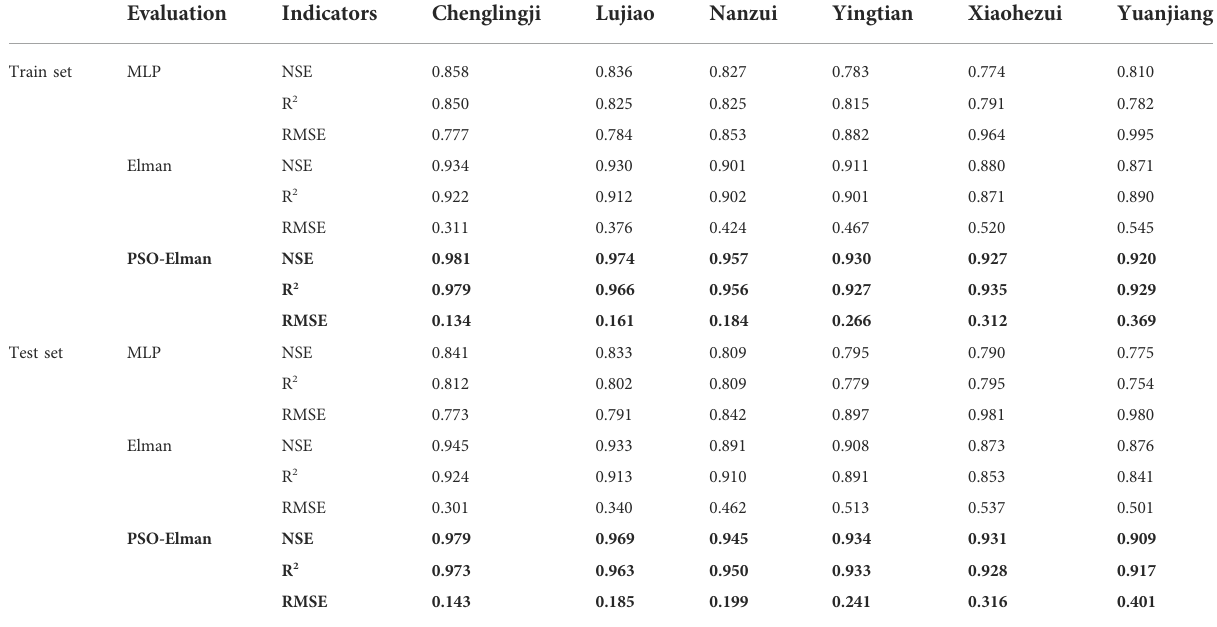
TABLE 1 Model performance evaluation using NSE, R 2 and RMSE. Evaluation